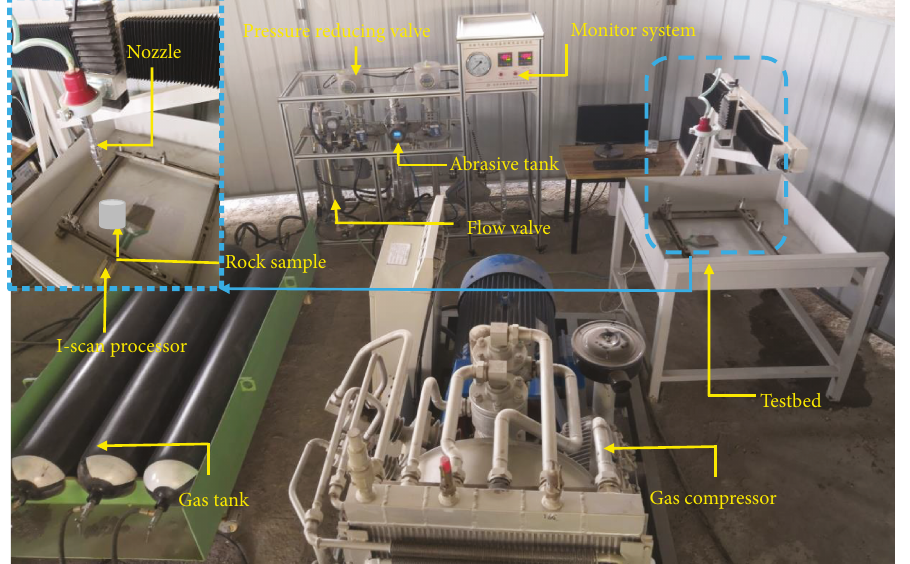
Figure 11: High-pressure abrasive air jet erosion